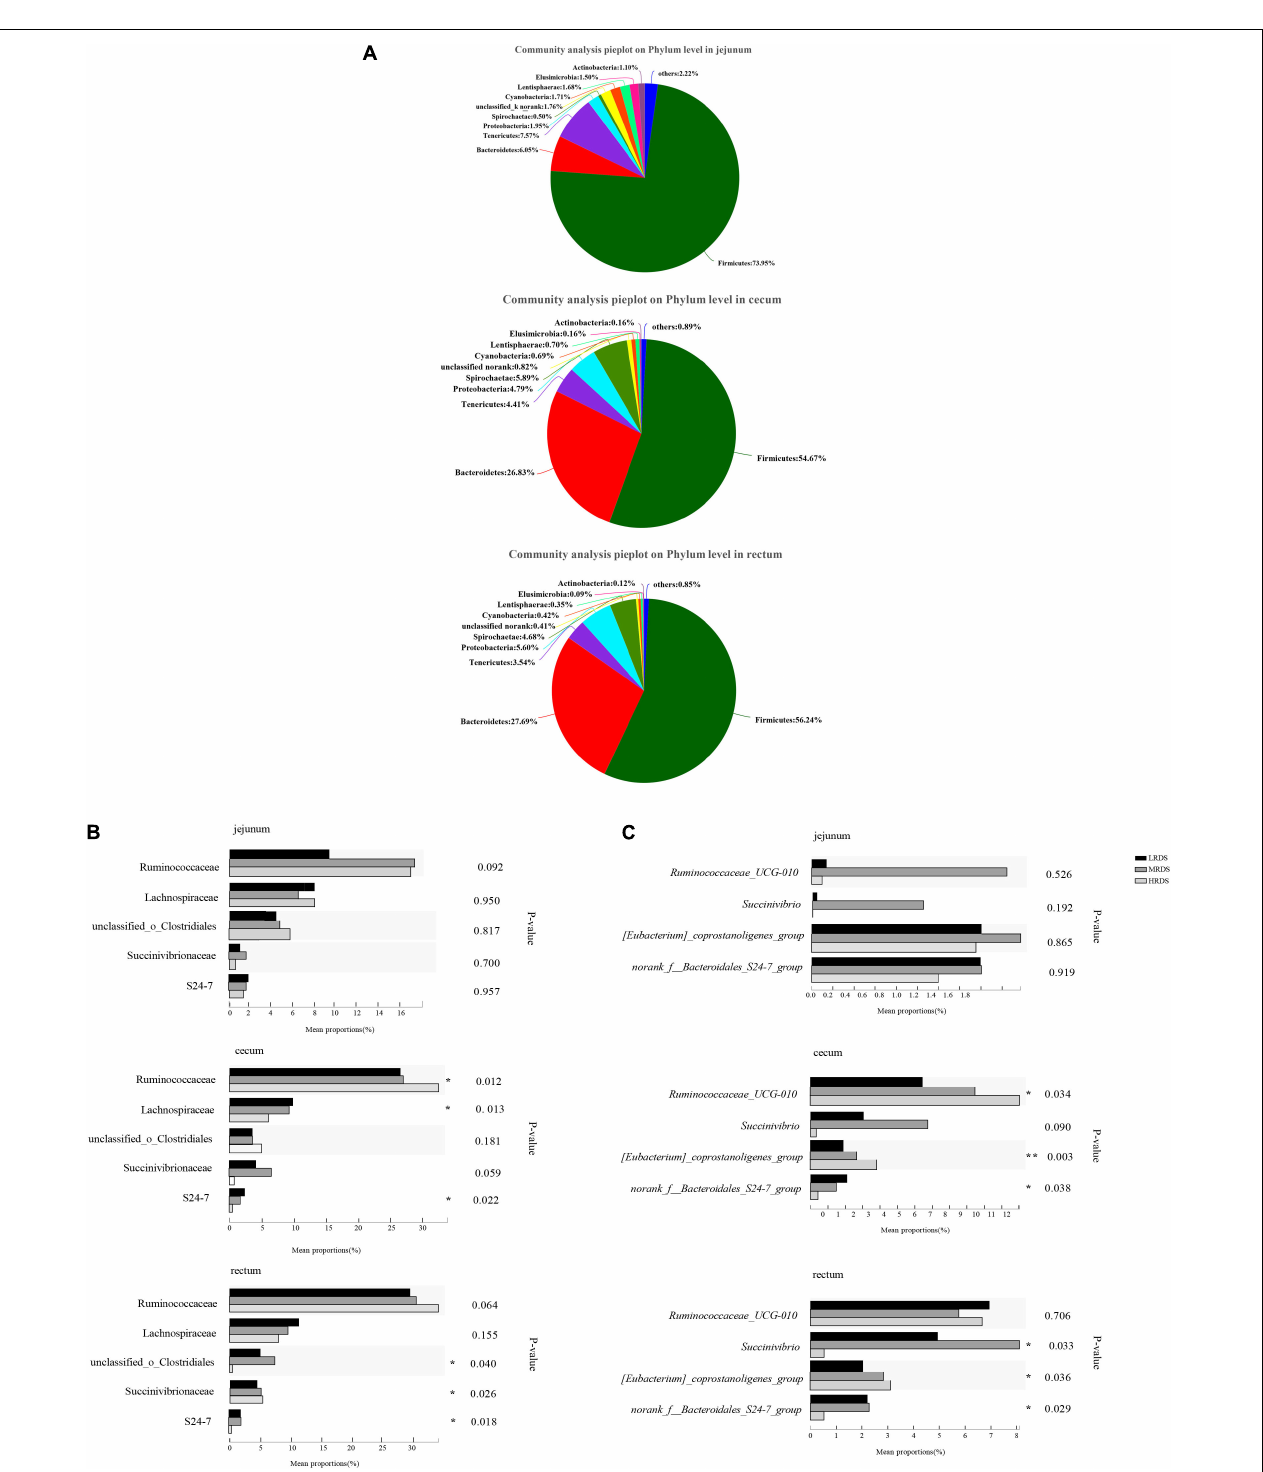
FIGURE 2 | Bacterial community composition in each intestinal tract region (A) on phyla level, (B) family level and, (C) genus level. (B) Comparison of relative abundances of the five main bacterial families (Ruminococcaceae, Lachnospiraceae, O. Clostridiales, S24-7, and Succinivibrion- aceae) among groups throughout the GIT region. (C) Comparison of relative abundances of the four main bacterial genera ( Ruminococcaceae UCG-010 , Eubacterium_coprostanoligenes, Bacteroidale_S24-7 _ group, and Succinivibrio ) among groups throughout the intestinal tract region. Asterisk (*) denotes significant correlations between hind-gut microbiome abundance with parameters * P < 0.05, ** P <